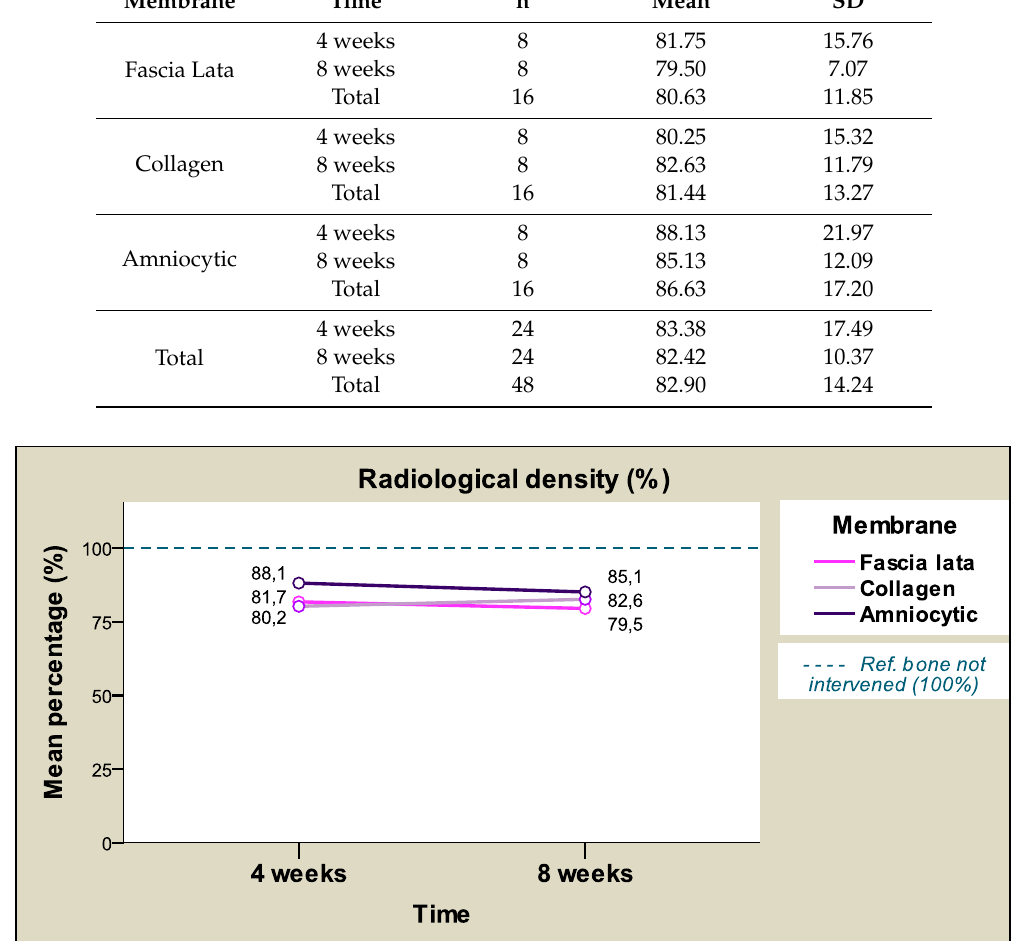
Figure 8 . The relative radiological density percentages (average) according to the membrane and time.